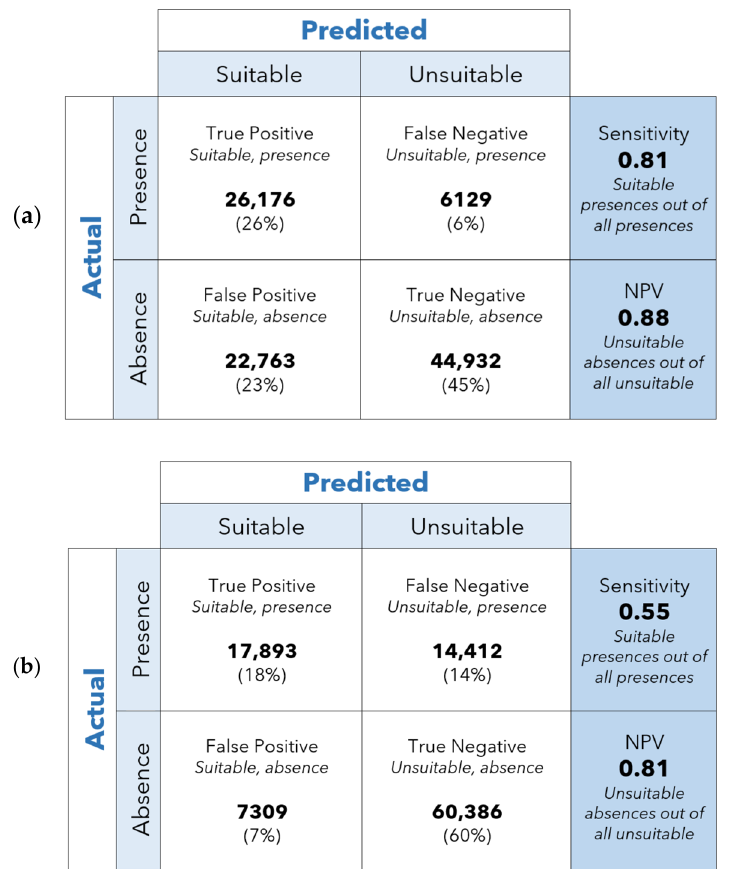
Figure 3. ( a ) Maxent and ( b ) Random Forest corn suitability confusion matrices. Sensitivity and NPV are used to compare models since these are the only two metrics computed without using false positive, a misleading